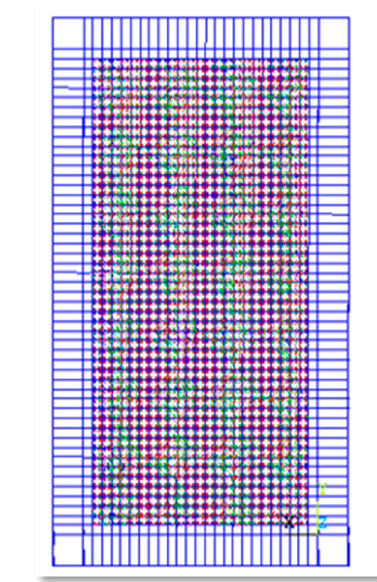
Figure 7. Local buckling, out-of-plane deflection for numerical specimen.